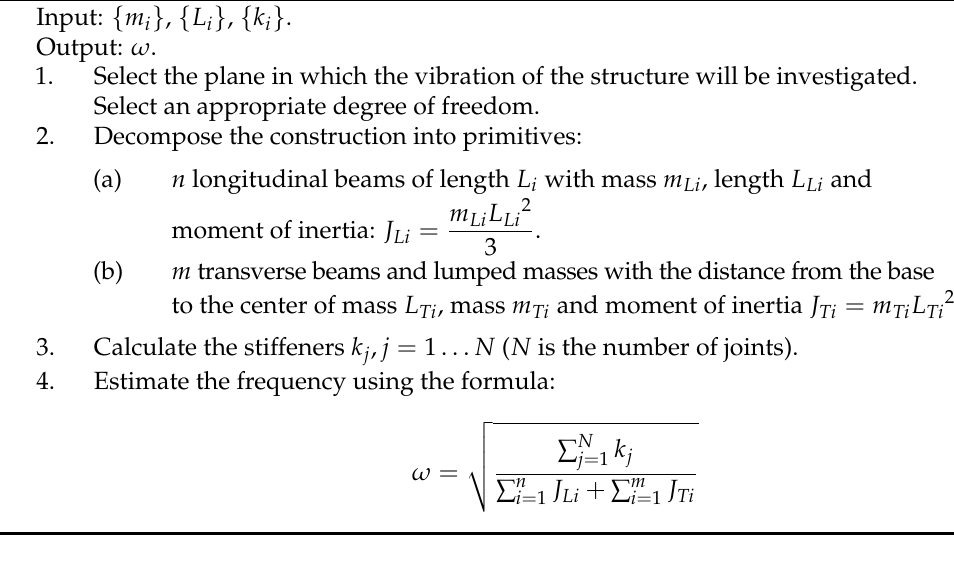
Algorithm 1: The algorithm for calculating Cartesian structure natural